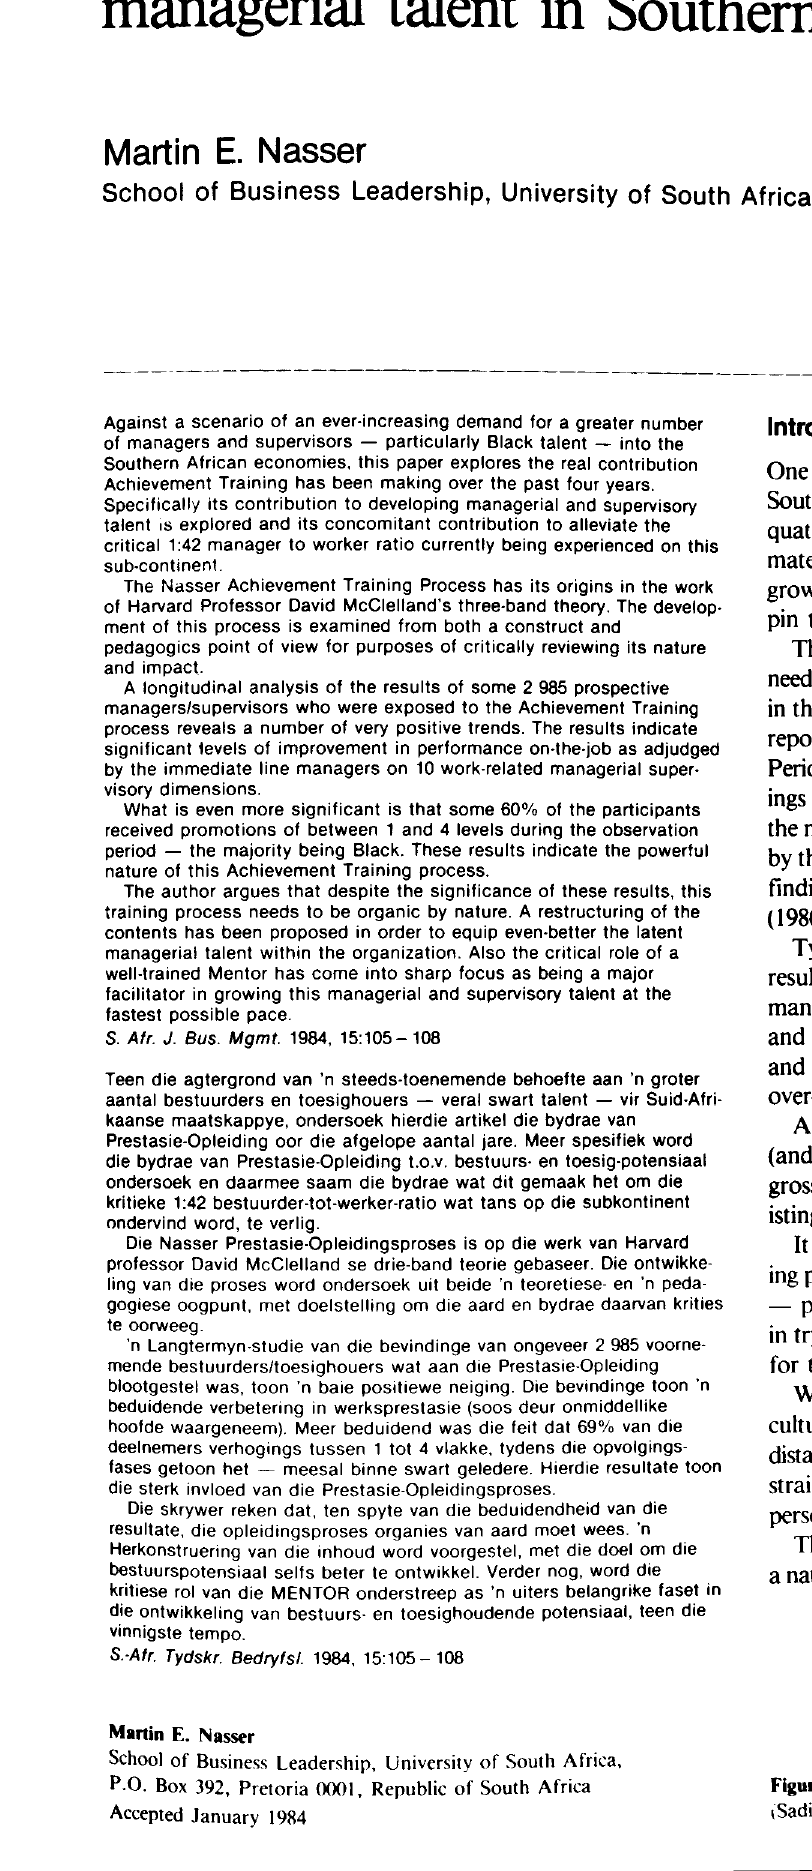
Figure t An international comparison of manager to worker